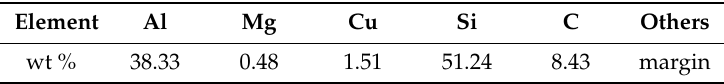
Figure 1. Micrograph of Al6063/SiC p /65p composites. Table 1. Chemical composition of Al6063/SiC p /65p composites.